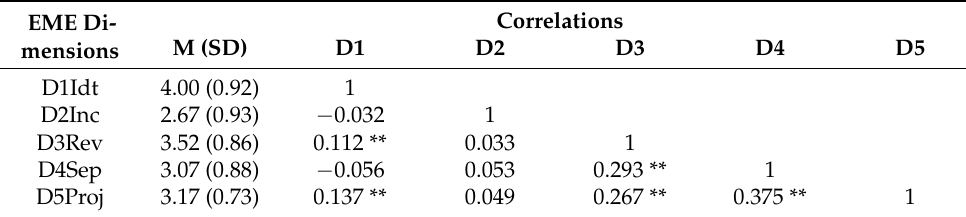
Table 2. Descriptive statistics and inter-factor